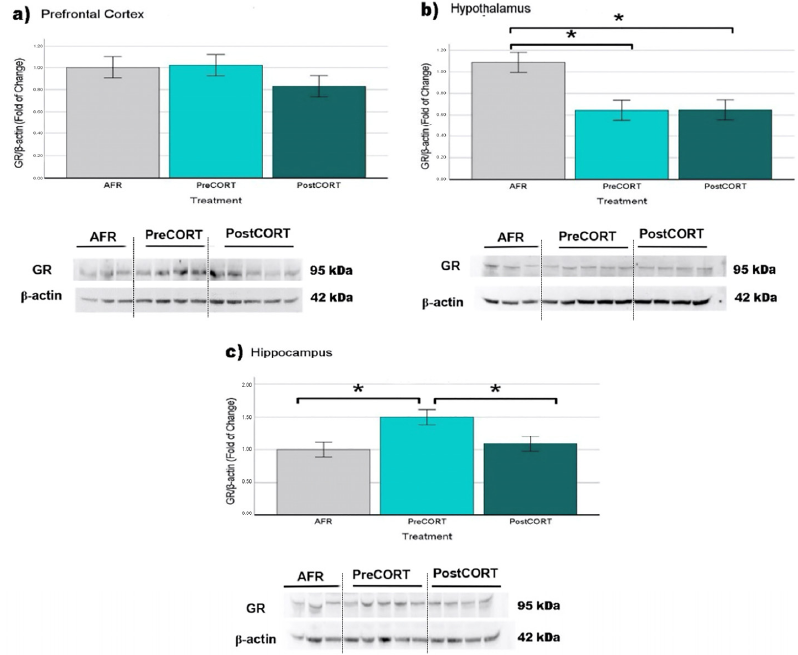
Figure 13. Glucocorticoid Receptors (GR) expression. Histograms and representative bands of GR expression in ( a ) prefrontal cortex, ( b ) hypothalamus and ( c ) hippocampus in AFR ( n = 8, prefrontal cortex; n = 6, hypothalamus; n = 8, hippocampus); PreCORT ( n = 8, prefrontal cortex; n = 6, hypothalamus; n = 8, hippocampus) and PostCORT ( n = 8 prefrontal cortex; n = 6 hypothalamus; n = 8 hippocampus) subjects. Each lane corresponds to different mice. Data are presented as mean ± SEM (* p < 0.05).